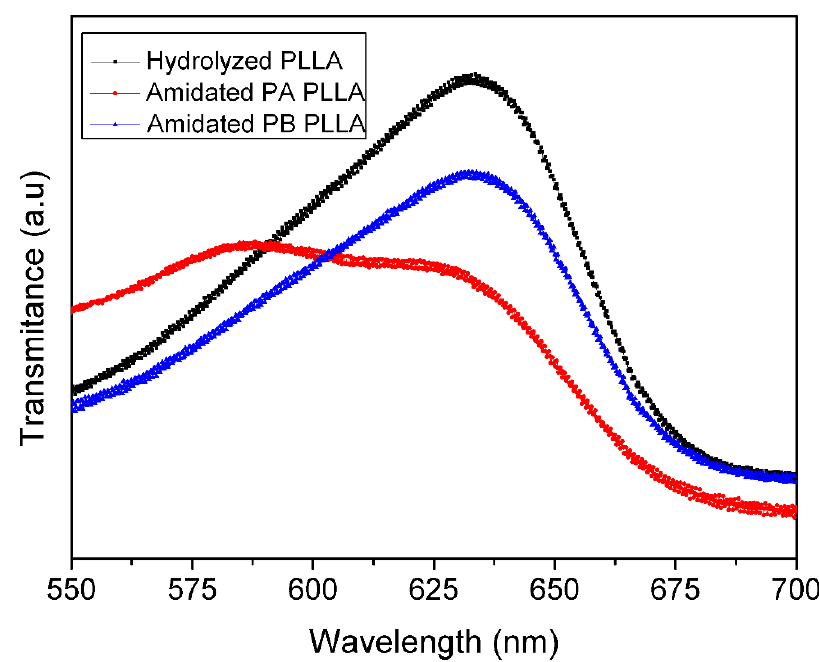
Figure 1. UV-Vis transmittance spectra of hydrolyzed PLLA and amidated PLLA.